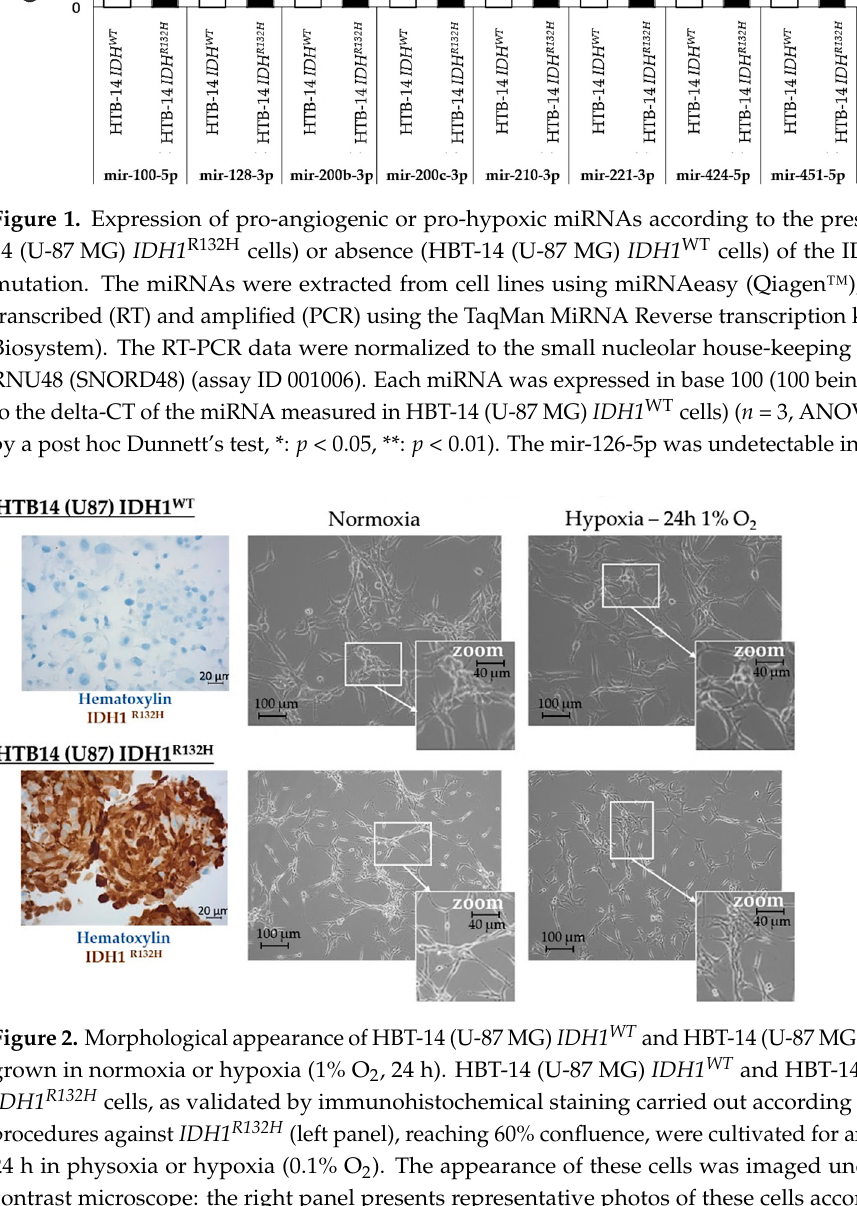
Figure 2. Morphological appearance of HBT-14 (U-87 MG) IDH1 WT and HBT-14 (U-87 MG) IDH1 R132H grown in normoxia or hypoxia (1% O 2 , 24 h). HBT-14 (U-87 MG) IDH1 WT and HBT-14 (U-87 MG) IDH1 R132H cells, as validated by immunohistochemical staining carried out according to standard procedures against IDH1R132H (left panel), reaching 60% confluence, were cultivated for an additional 24 h in physoxia or hypoxia (0.1% O 2 ). The appearance of these cells was imaged under a phase contrast microscope: the right panel presents representative photos of these cells according to the culture condition (normoxia/hypoxia).